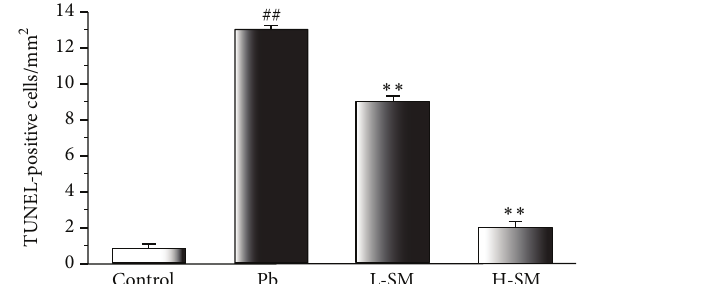
Figure 6: Effects of SM injection on the apoptosis of mouse kidneys. Representative microscopic photographs of TUNEL-stained kidney sections were shown (magnification 400x). Very few tubular and interstitial cells were TUNEL-positive in the control group. The number of apoptotic cells markedly increased with lead acetate injection. Both L-SM and H-SM treatments significantly decreased the number of TUNEL-positive cells in the kidney; the arrow heads pointed out the apoptotic cell nucleus. The histogram showed the relative proportion of TUNEL-positive cells in the kidney of mice. Data are expressed as mean ± SD of 20 mice. ## 𝑃 < 0.01 , compared with control group; ∗∗ 𝑃 < 0.01 , compared with Pb